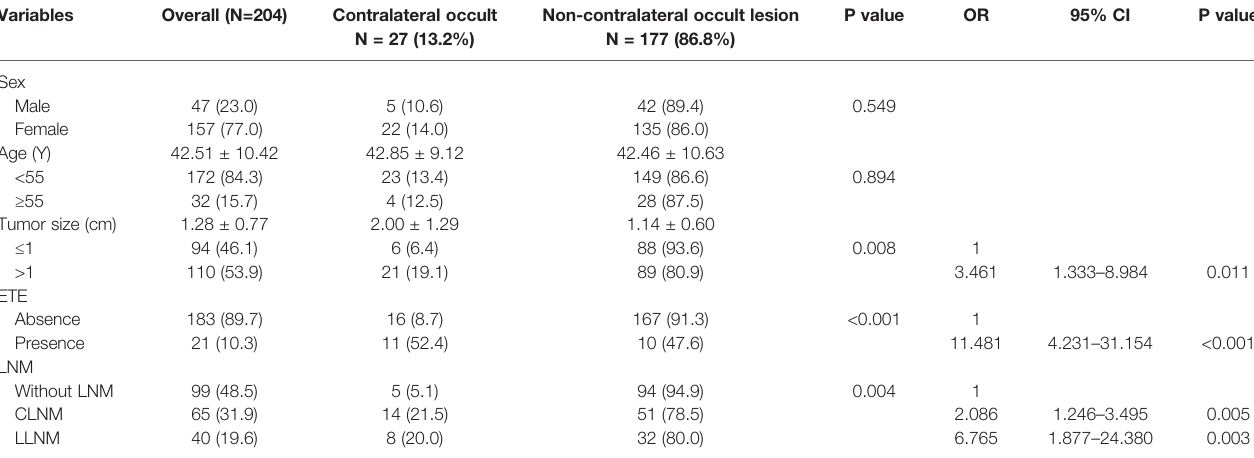
TABLE 1 | Associations between clinicopathological characteristics and contralateral occult carcinoma in PTC patients.